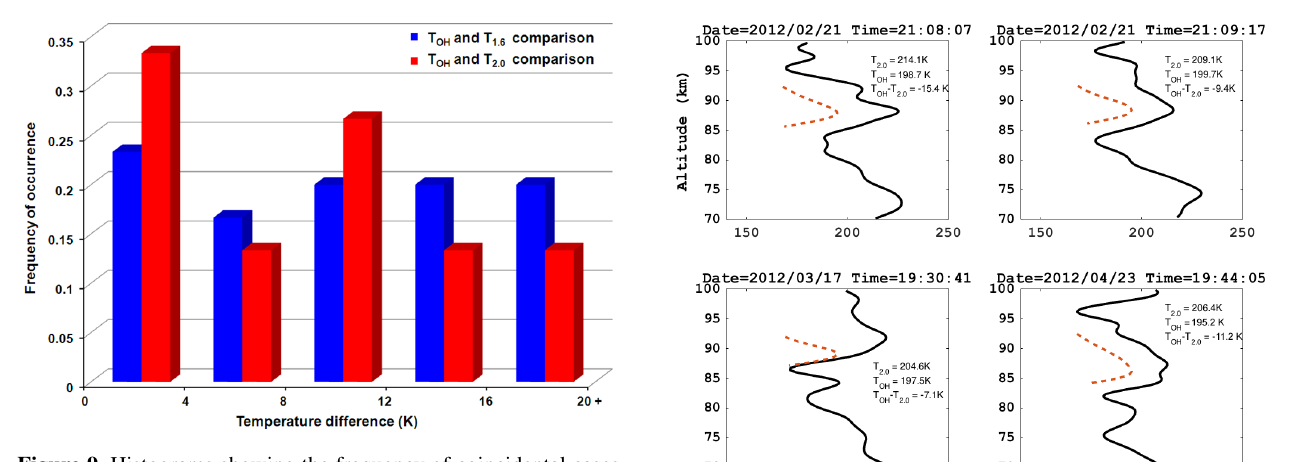
Figure 9. Histograms showing the frequency of coincidental cases against the observed difference of ground-based T OH measurements and SABER OH-equivalent temperatures ( T 1 . 6 and T 2 . 0 ) at steps of 4K. Figure 10. Typical examples of SABER kinetic temperature pro- files marked by strong inversions and nearly co-located OH layer. In each plot, the temperature measurements are shown by solid curves, while the broken curve symbolizes the OH 2.0µVER over